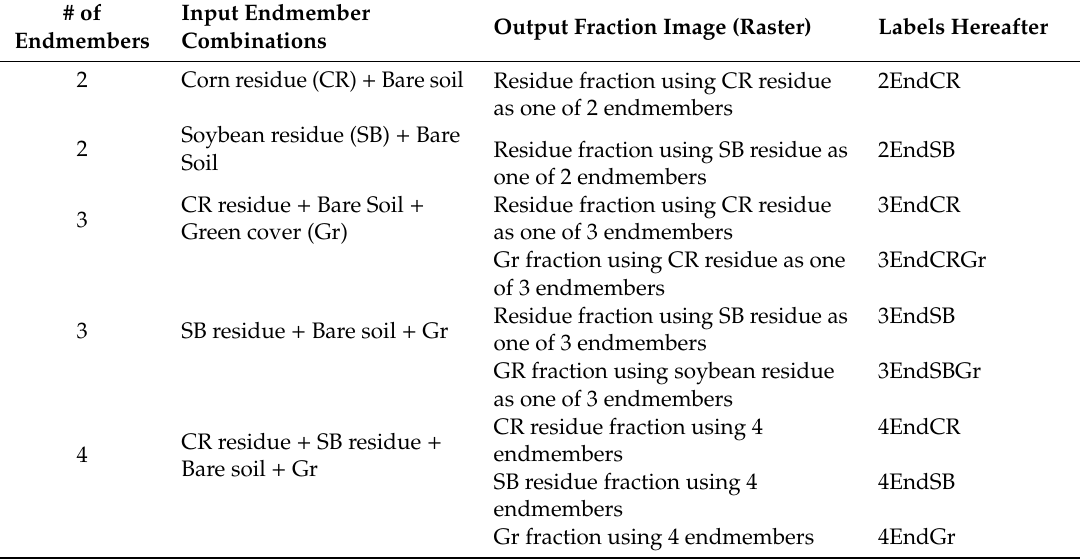
Table 3. Endmember combinations used in spectral unmixing and resulting fraction images analyzed.